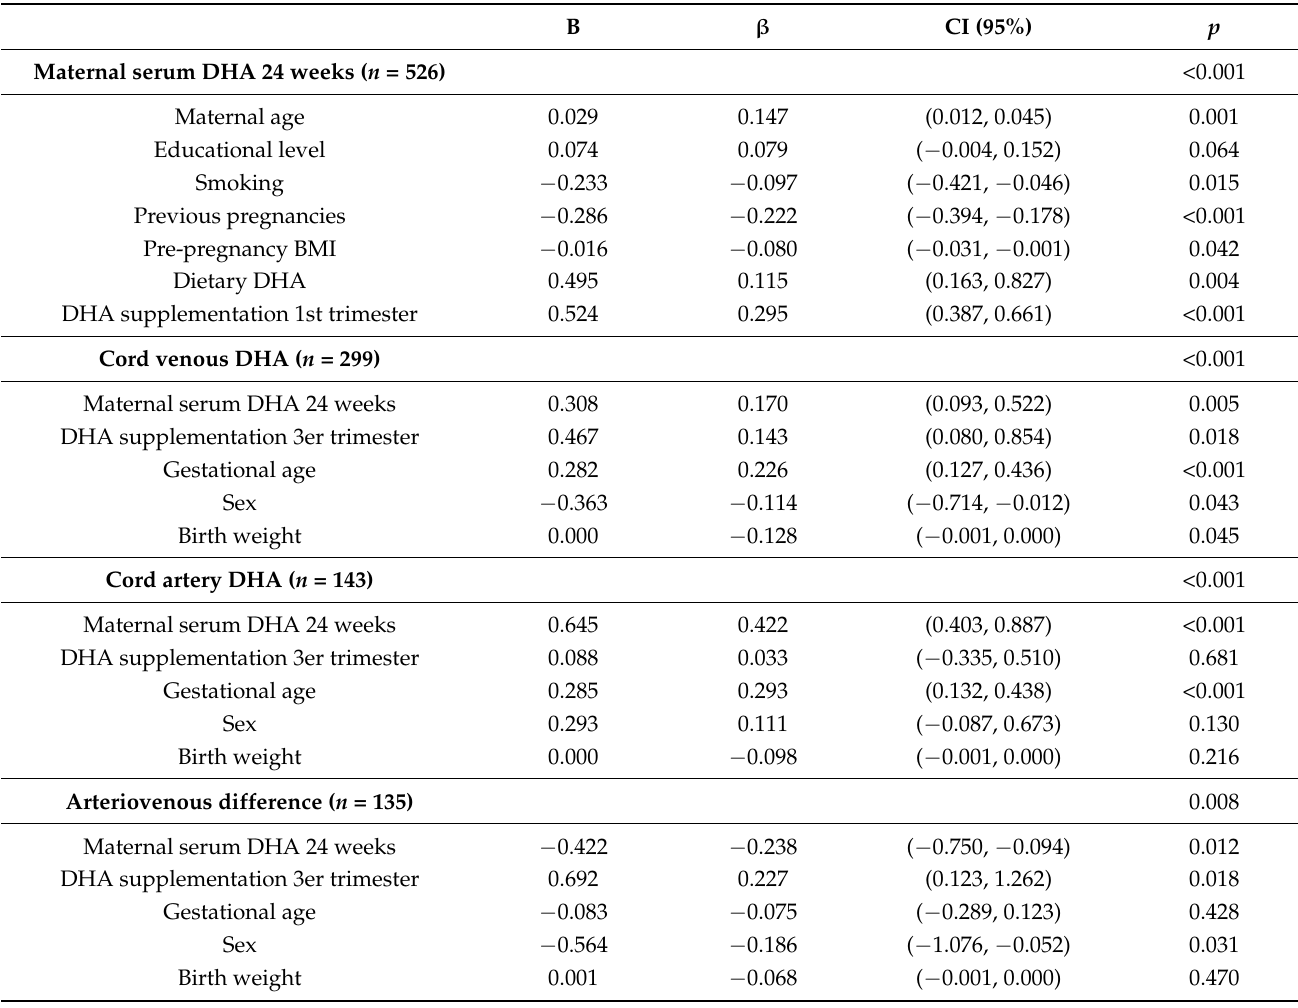
Table 3. Associations between serum docosahexaenoic acid (DHA) percentage and maternal/neonatal variables. The NELA study